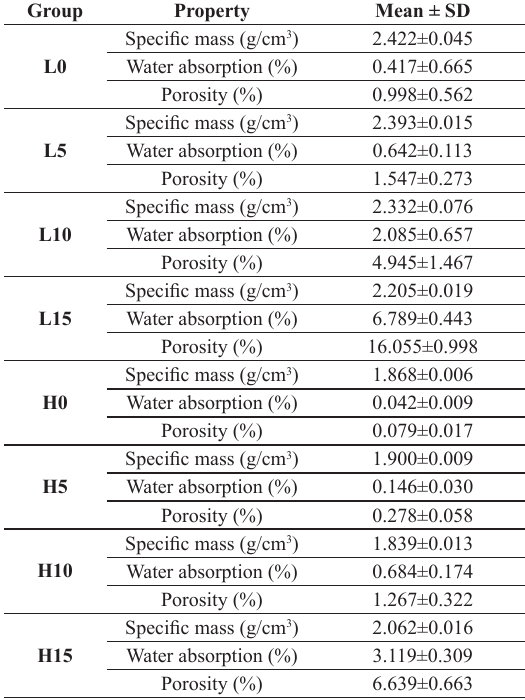
Table 2. Specific mass, porosity, and water absorption of sintered groups at 700 and 800 °C. Group